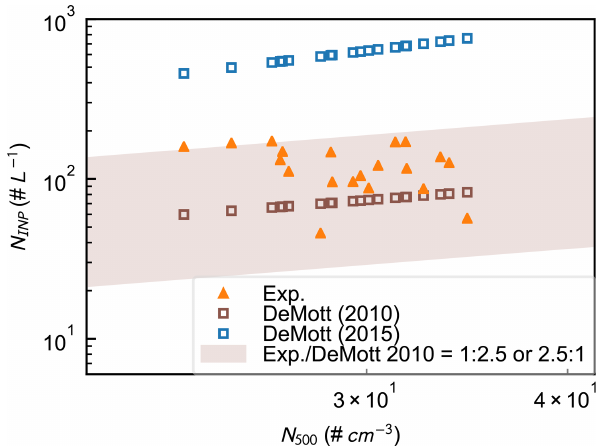
Figure 8. Intercomparison of measured (solid orange triangles) and predicted (hollow blue and brown squares) N INP during the dust event. The prediction is based on the parameterizations that link N INP with the number concentration of particles larger than 500nm ( N 500 ) at a specific temperature (DeMott et al., 2010, 2015).